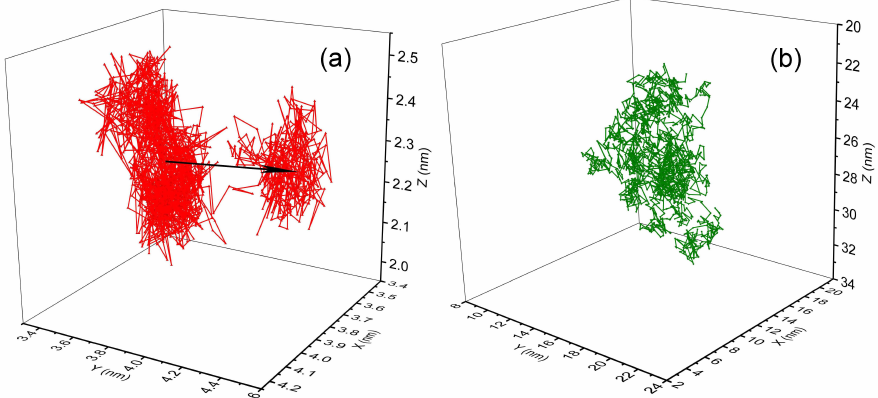
Figure 12. The 150 ns trajectory of fullerene in: ( a ) PS melt; and ( b ) PP melt. The arrow indicates a jump